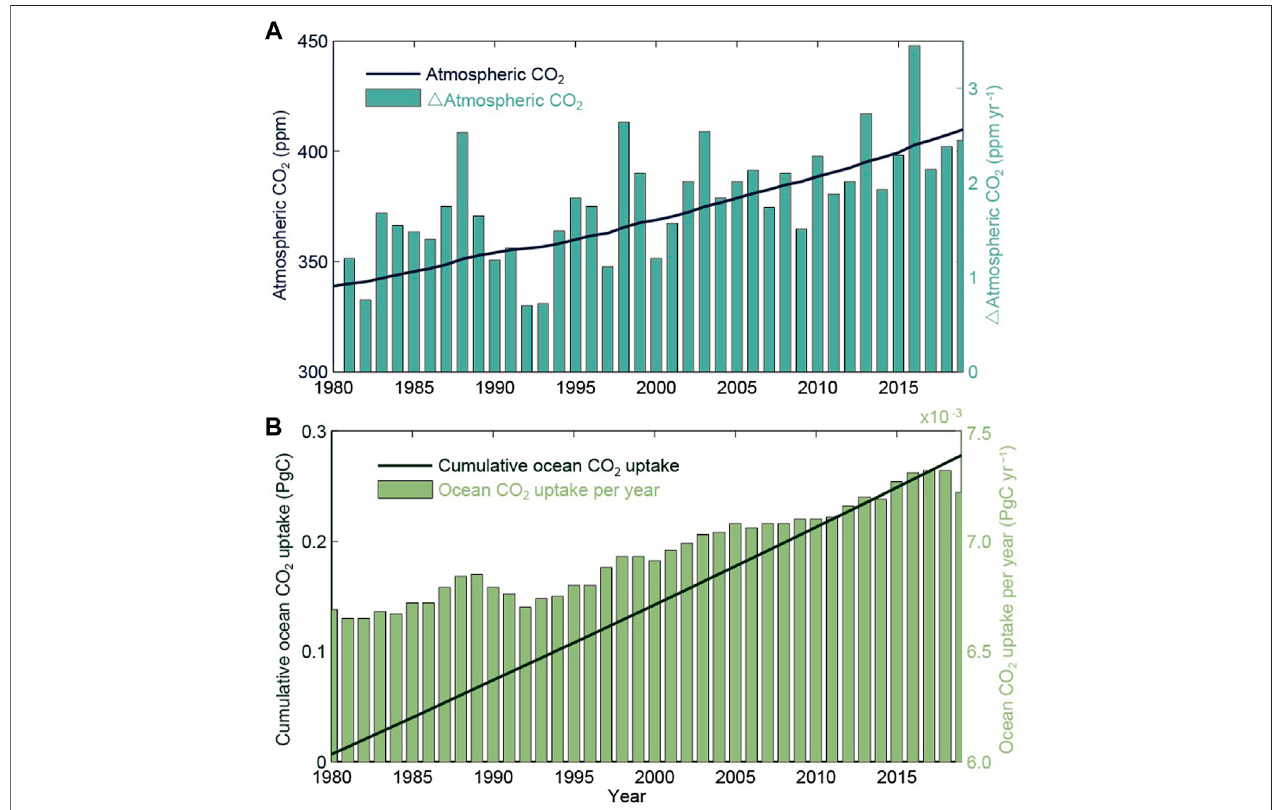
FIGURE 4 | (A) Prescribed atmospheric CO 2 concentration and (B) model-simulated time series of annual cumulative oceanic CO 2 uptake in Zhejiang offshore (lines). Changes of atmospheric CO 2 concentration relative to the previous year and oceanic CO 2 uptake per year are also shown by the boxes.